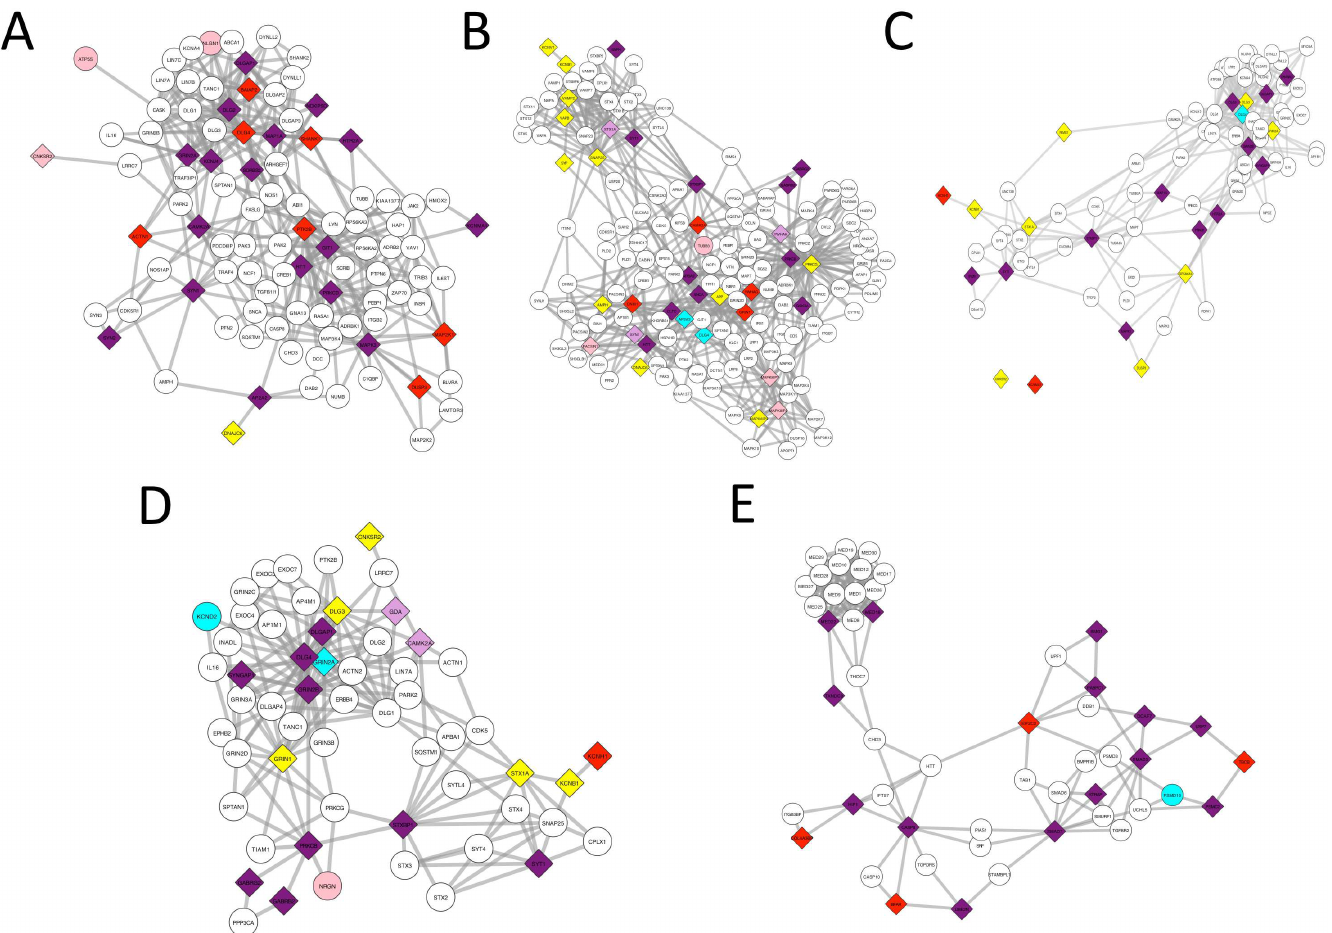
Fig 5. Results of Hotnet2 and Conflux on a literature reported disease subnetwork. (A) Schizophrenia. (B) Epilepsy.(C) ASD1. (D) ASD2. (E) Ovarian Cancer. The nodesin purpleare genes found by both Hotnet2 and Conflux.The nodes in cyan were only found by Hotnet2. The nodesin red and pink are respectively nodes detected (marginal (cid:21) 0.2) or having suggestiveevidence(marginal (cid:21) 0.05) by Conflux. Nodes colored in plum were found by Hotnet2 but only have suggestive evidencein Conflux. Yellow nodesare true causal genesthat were neither found nor suggestedby any method. The diamondshaped nodesare the true causal genes. The sample size used is n =